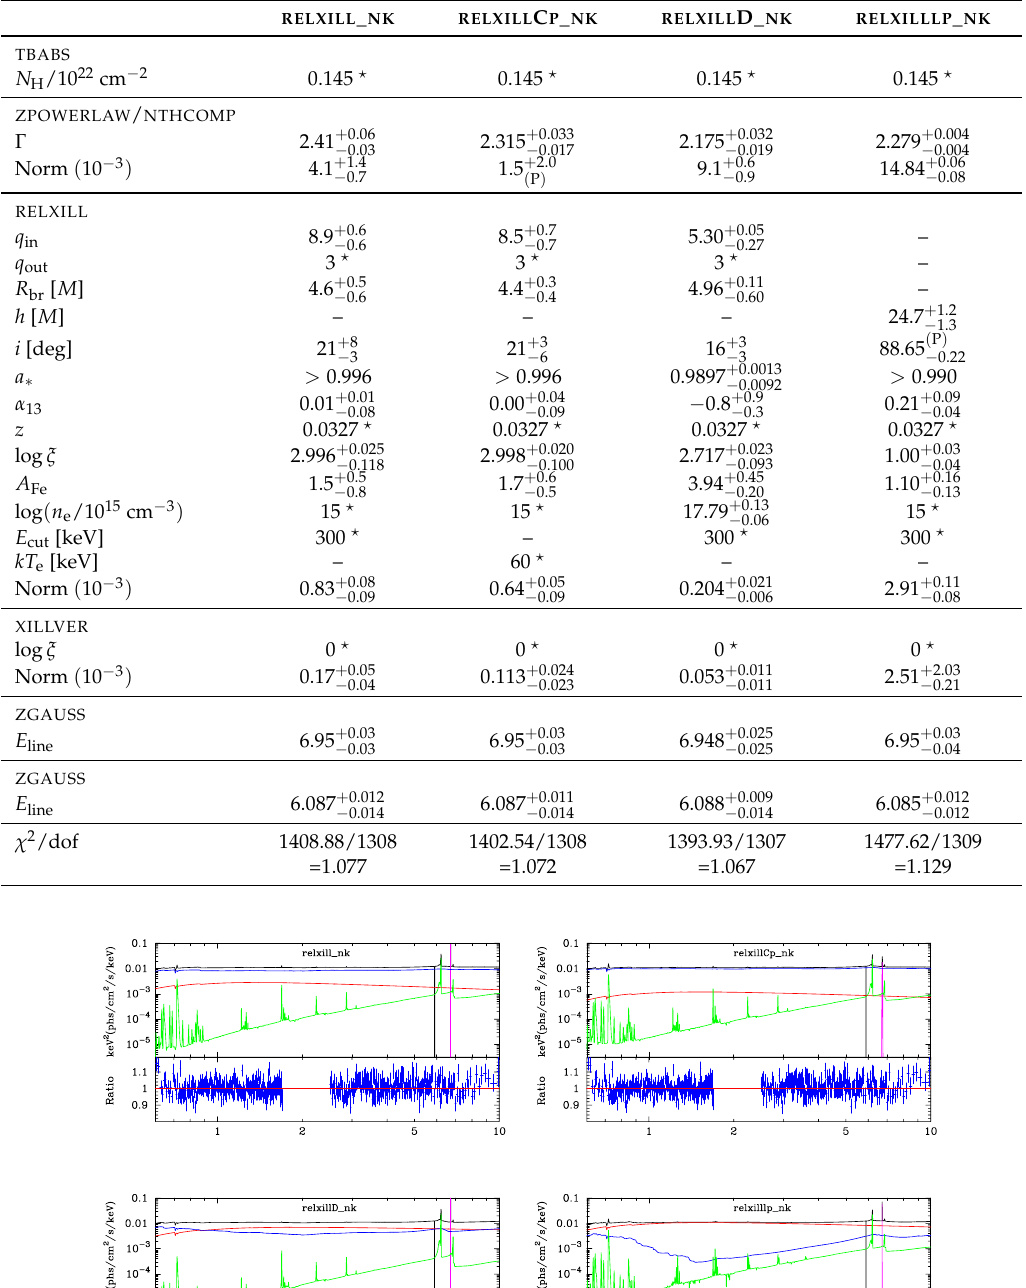
Table A2. Summary of the best-fit values for the supermassive black hole in Ark 120. In XILLVER , ξ is the ionization parameter of the distant reflector. In ZGAUSS , E line is the energy of the line. (cid:63) indicates that the parameter is frozen to that value in the fit.